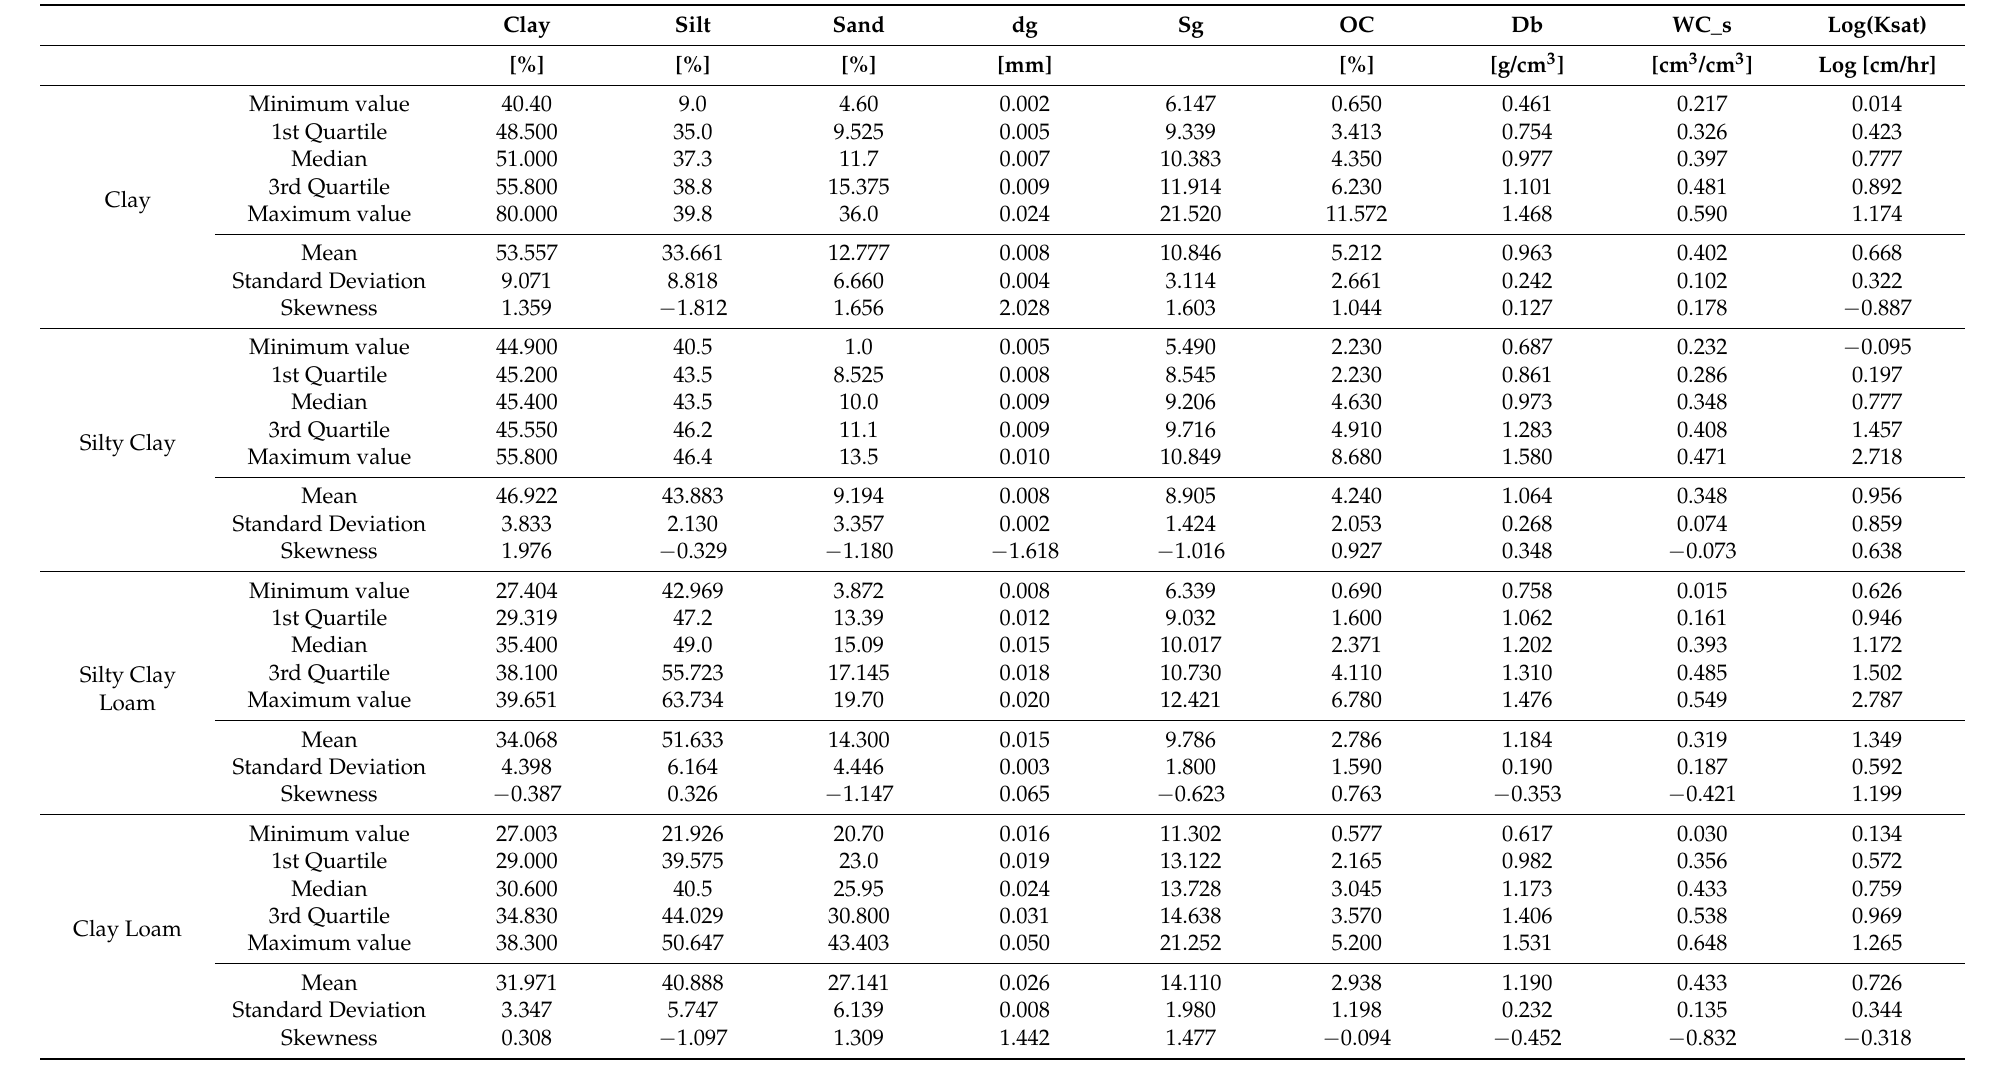
Table 1. Characteristics of the training dataset